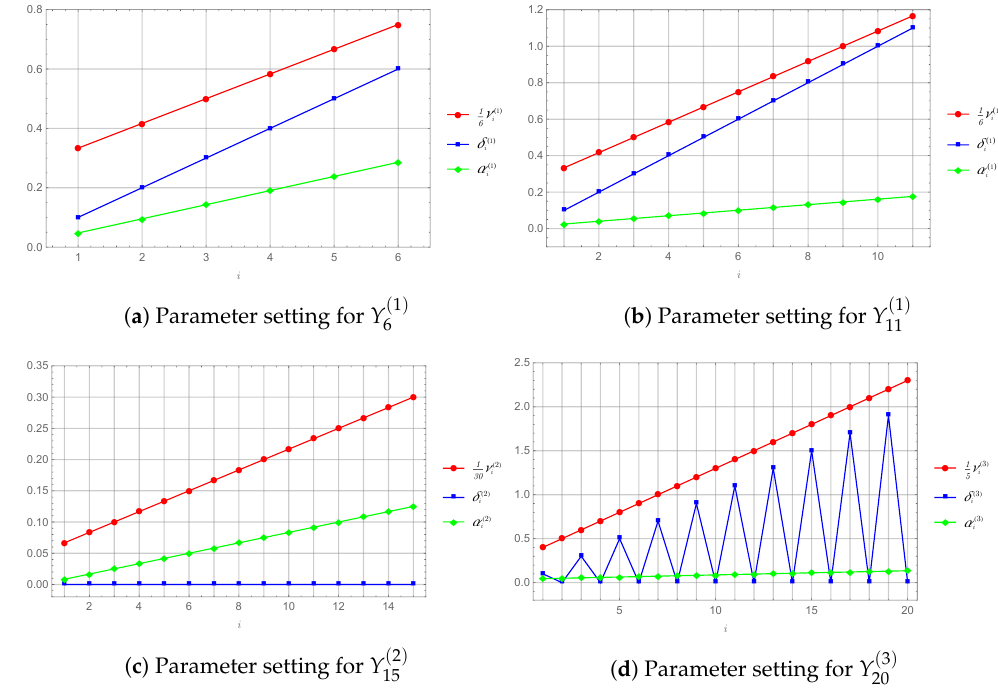
( j ) with a scaling i